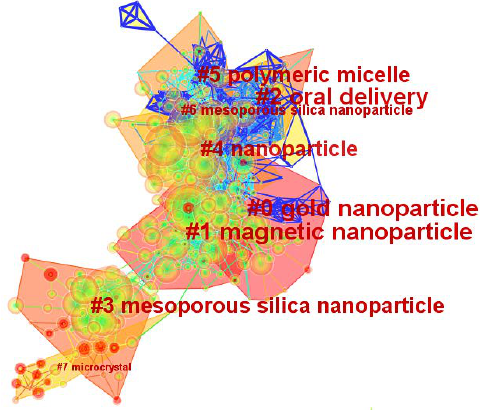
Figure 2. Clusters visualization based on a document co-citation network.